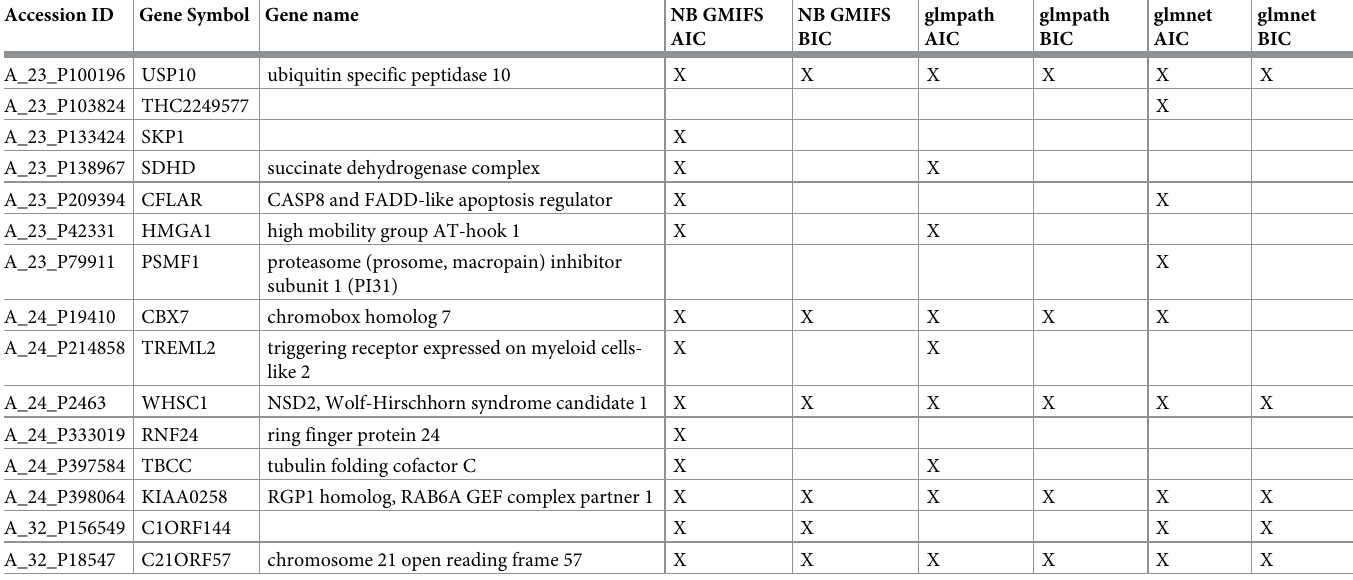
Table 1. Genes associated with MN frequency in the AIC and BIC selected NB GMIFS models.